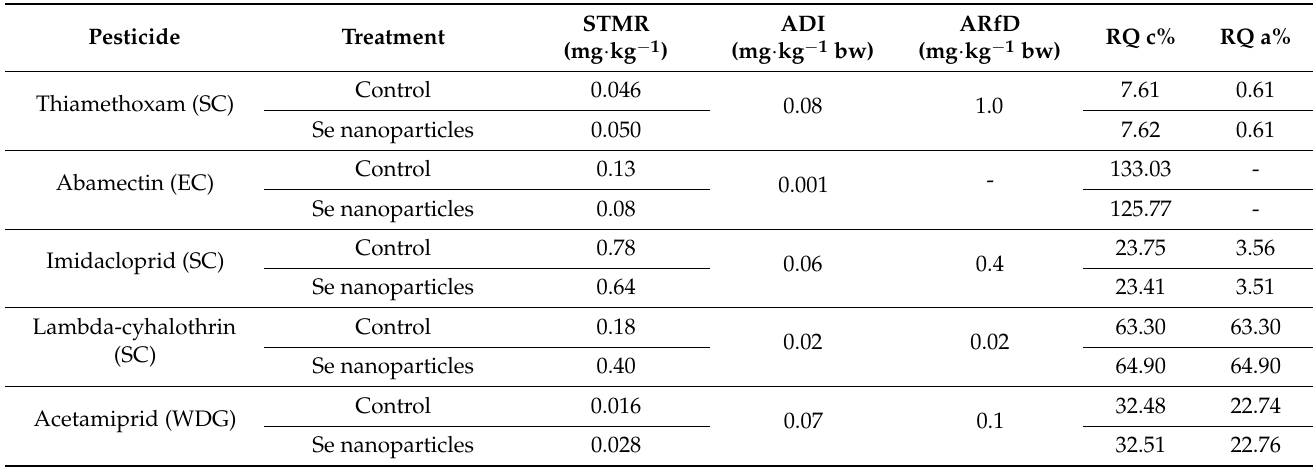
Table 9. Risk quotient and risk probability of 5 pesticides in celery after pesticide application at the recommended dose combined with 2 g · ha − 1 Se